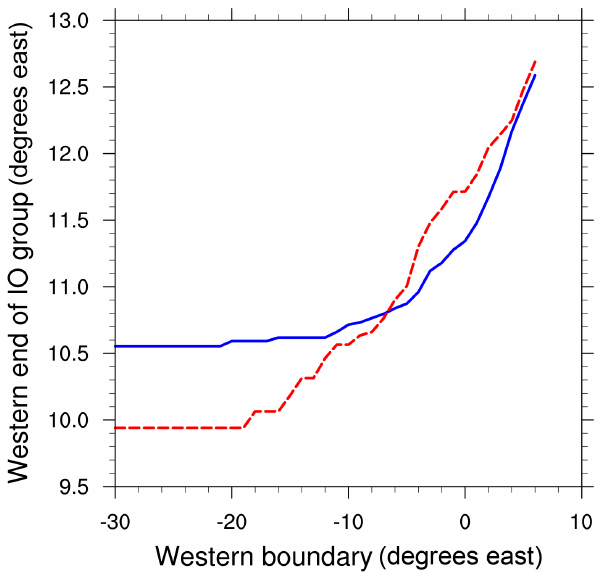
Figure 5. Convergence of the western limit of the group of Indian Ocean points with the position of the western boundary of the do- main on which the algorithm is applied for model data (blue) and satellite data